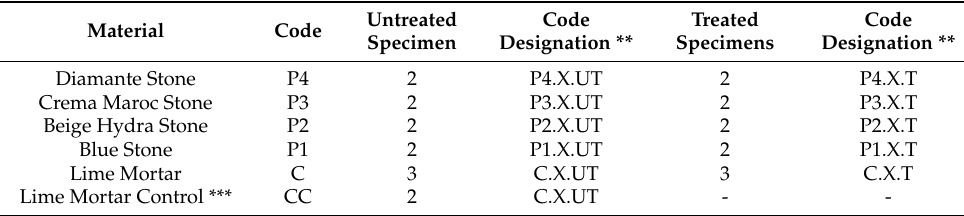
Table 1. Specimens analyzed for this